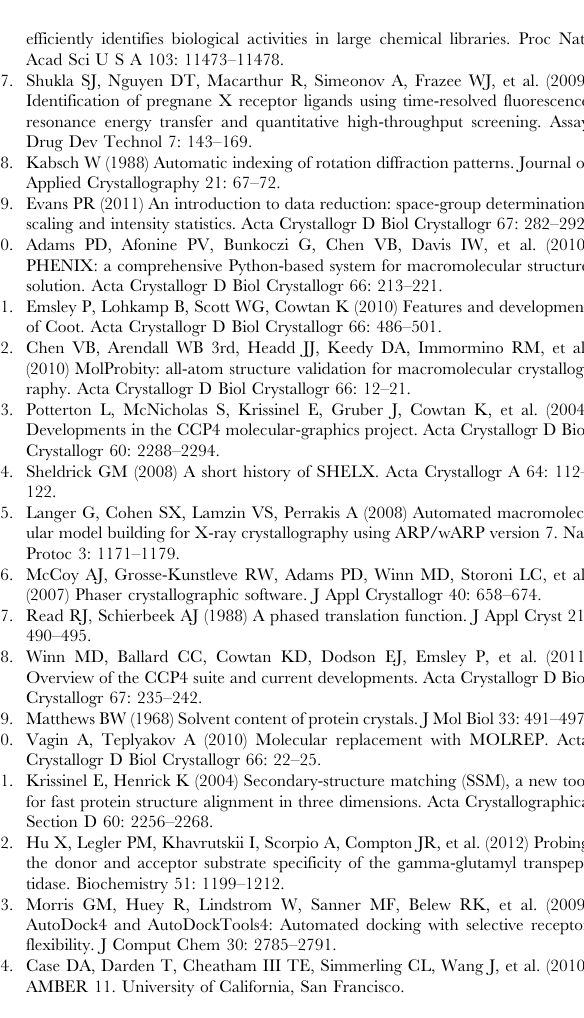
Table S1 1536 well protocol of PyAeADHII assay at Crystallographic data for